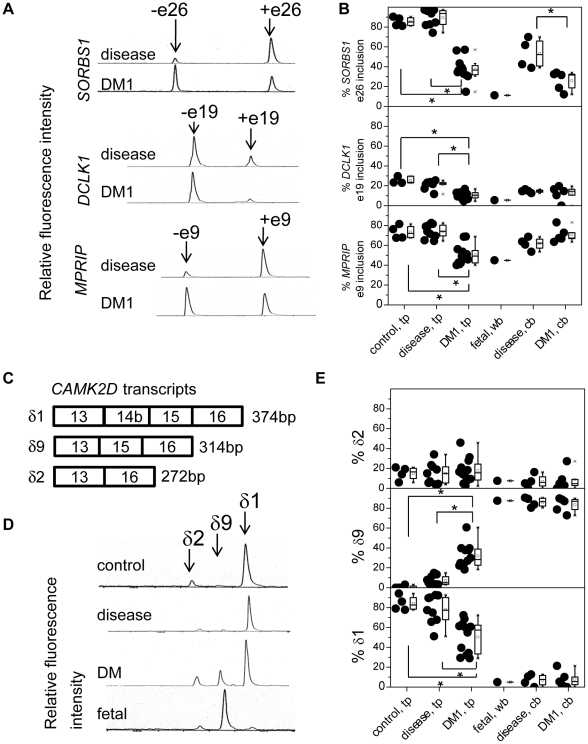
Aberrant splicing events in Mbnl1
ΔE3/ΔE3 brain are also observed in the human DM1 brain.We compared brain RNA from normal control temporal cortex (control, tp, n = 4), disease control temporal cortex (disease, tp, n = 9), myotonic dystrophy type 1 temporal cortex (DM1, tp, n = 12), fetal control whole brain (fetal, wb, n = 1), disease control cerebellum (disease, cb, n = 4), and DM1 cerebellum (DM1, cb, n = 5). (A) Representative RT-PCR products detected with microchip electrophoretic separation using SV1210 software on the Hitachi SV1210 from exclusion and inclusion of exon 26 of SORBS1 (upper), exon 19 of DCLK1 (middle), and exon 9 of MPRIP (bottom). (B) Graphical representation of RT-PCR analysis depicting percentages of exon 26 inclusion of SORBS1 (upper), exon 19 inclusion of DCLK1 (middle), and exon 9 inclusion of MPRIP (bottom). (C) Transcripts of CAMK2D. (D) Representative RT-PCR products from CAMK2D isoforms: δ2(−exon14b−exon15), δ9(−exon14b+exon15), and δ1(+exon14b+exon15) indicated by each arrow. (E) Graphical representation of RT-PCR analysis depicting percentages of δ2 (upper), δ9 (middle) and δ1 (bottom). Mann-Whitney U test was used for calculating the p value. Statistically significant differences (p<0.05) are indicated by an asterisk.